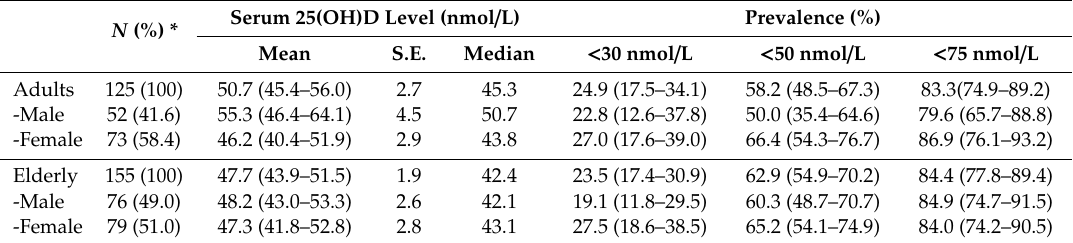
Table 2. Yearly population-weighted (age, sex) serum 25(OH)D levels and prevalence of serum 25(OH)D levels < 30, < 50, and < 75 nmol / L (95% CI) for adults (18–64 years) and elderly (65–74